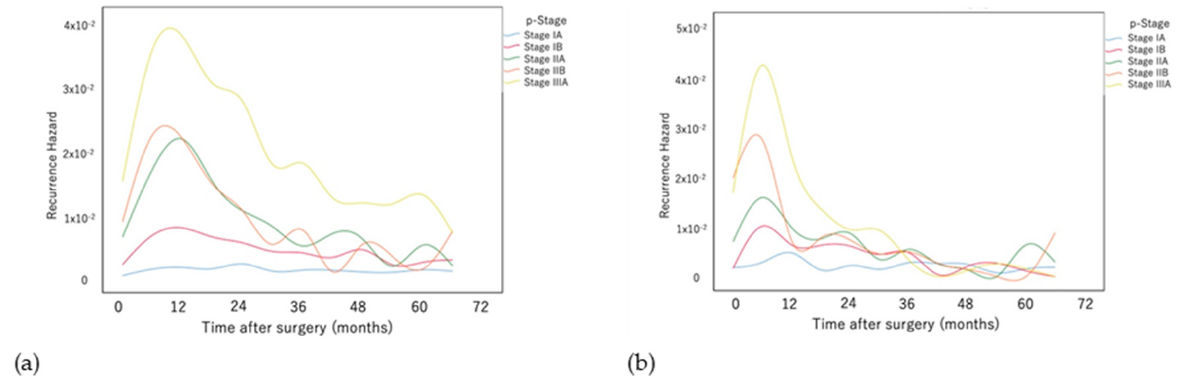
Figure 4. Comparison of the recurrence hazard functions of patients with ( a ) adenocarcinoma and ( b ) squamous cell carcinoma at each pathological ( b ) squamous cell carcinoma at each pathological stage.